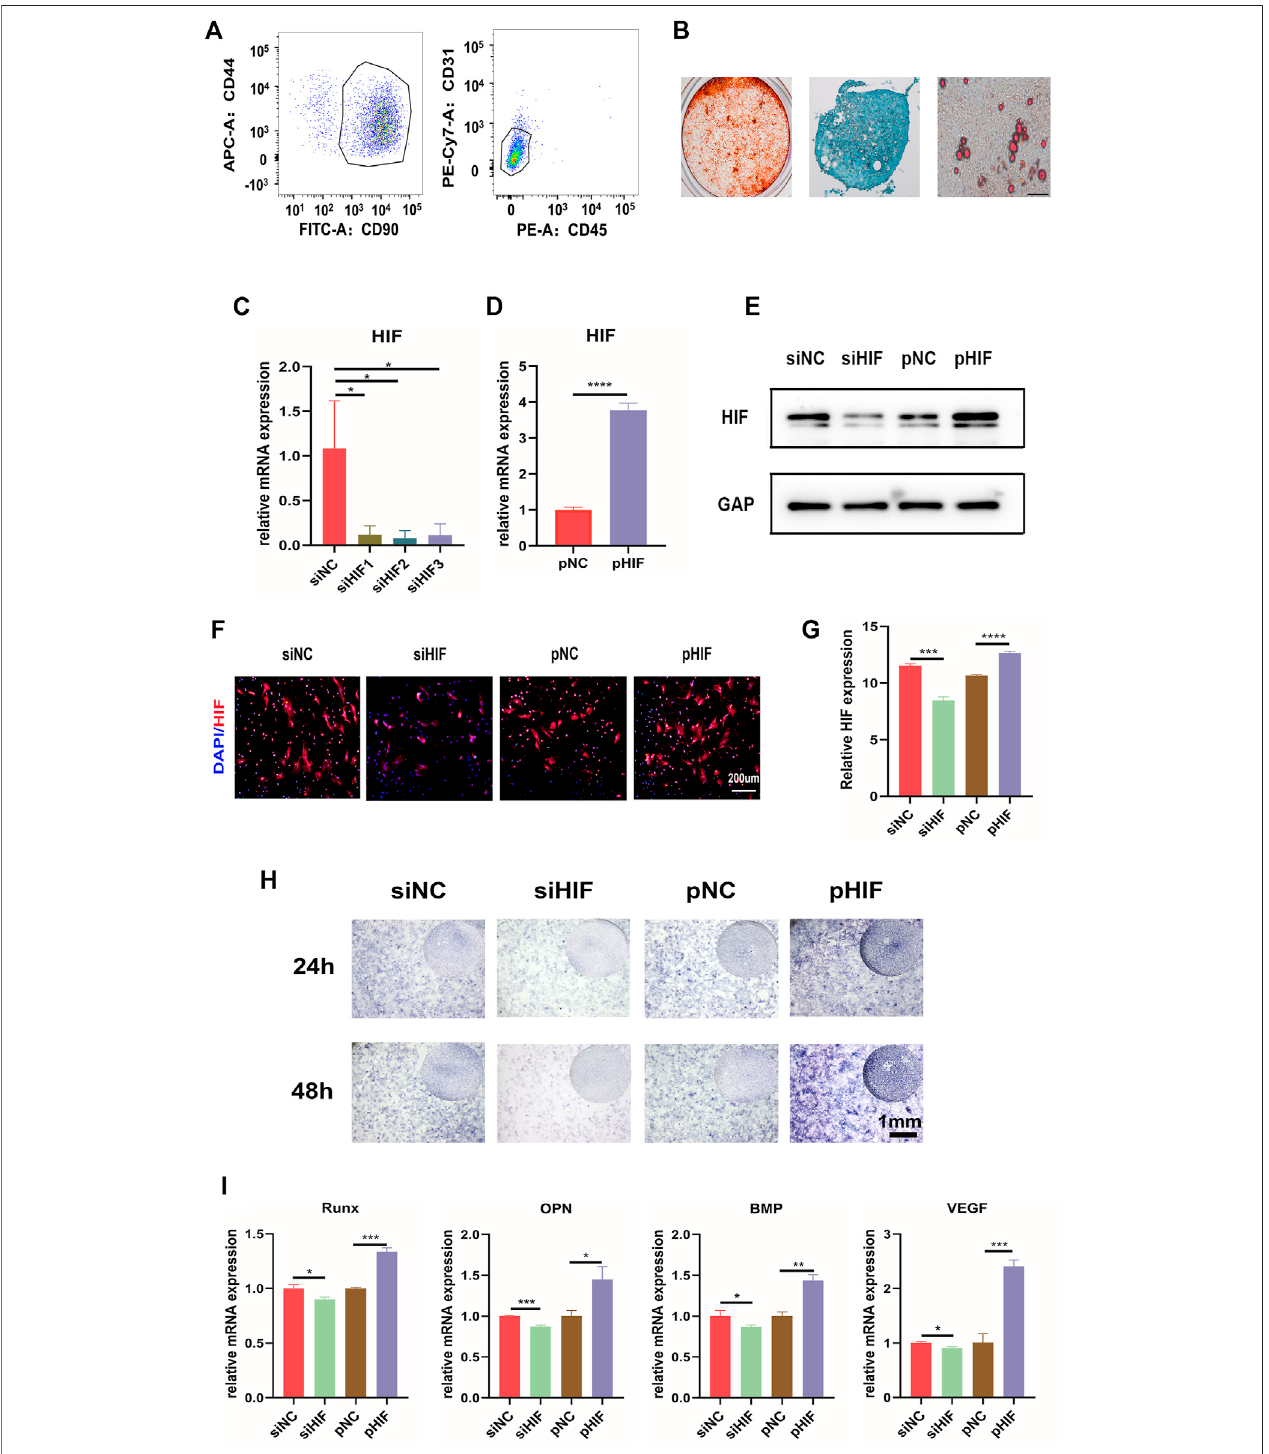
FIGURE 3 | HIF-1 α is important in in vitro osteogenesis of PDSCs. (A) Flow cytometry results of PDSCs isolated from mice calvarial periosteum showing the cells double-positive forCD44andCD90(91.1%)and double-negativeforCD45and CD31(95.9%). (B) Invitro osteogenic(21D), chondrogenic(14D), andadipogenic (21D) differentiationofPDSCs(scarbar:100 μ m). (C,D) Theexpression ofHIF-1 α aftersiHIF-1 α andpHIF-1 α transfection inPDSCsbyqRT-PCR. (E) Western blottingofHIF- 1 α . (F,G) The immuno fl uorescence for HIF-1 α in transfected PDSCs and the semi-quanti fi cation. (H) ALP staining of the PDSCs after transfection. (I) The expression of the osteogenic related genes. * indicates the signi fi cance tests between groups: * p < 0.05, ** p < 0.01, and *** p < 0.001.